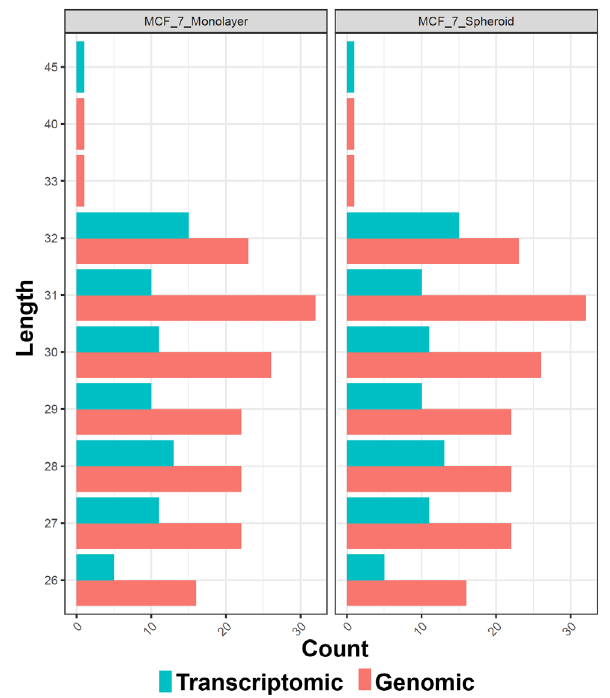
Figure 5. Barplots of the length of piRNA classes with respect to each experimental group (in this case monolayer and spheroid MCF7). The colours indicate the two different methods of quantification (genomic and